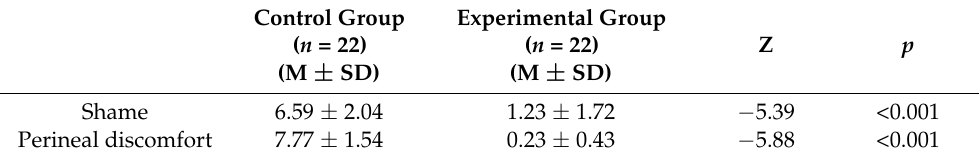
Table 1. Effect of wearing perineal underwear.